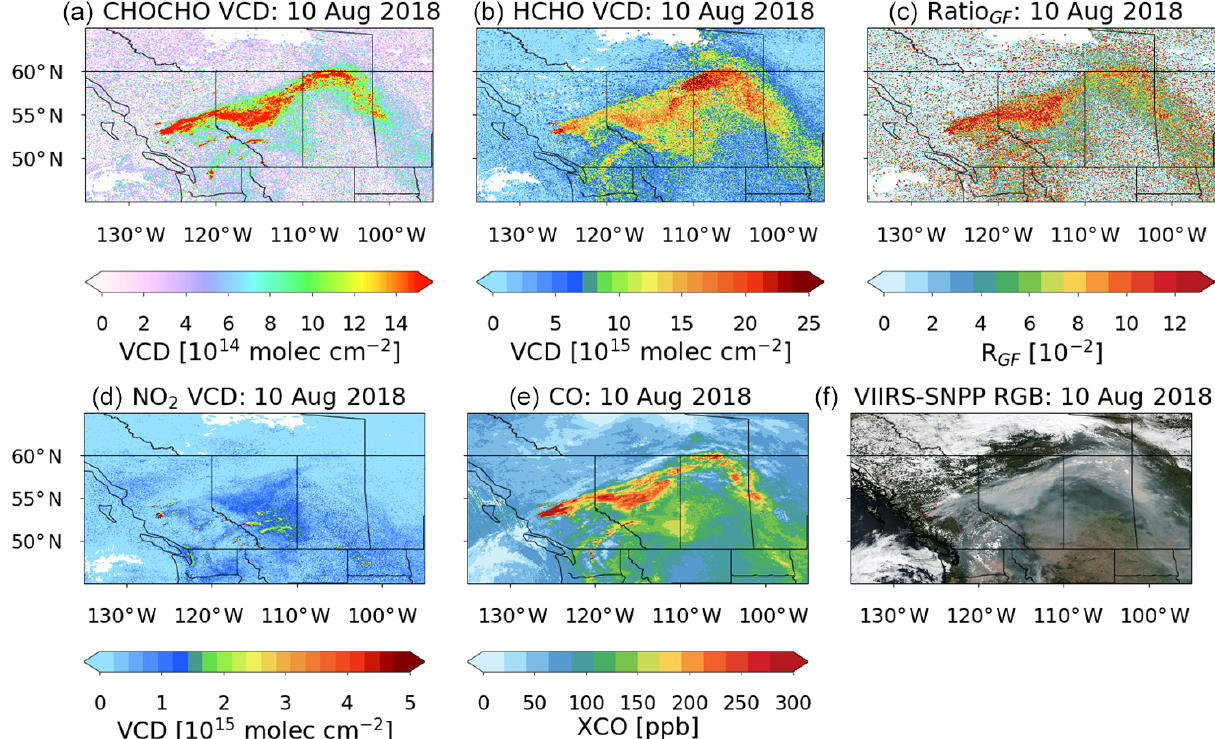
Figure 8. Panels (a) , (b) , (d) , and (e) show the CHOCHO, HCHO, NO 2 , and CO columns, respectively, retrieved from S5P measurements for 10 August 2018. Note that CO columns are unfiltered and only represent a qualitative description of the plume. The AMFs used for CHOCHO, HCHO, and NO 2 are appropriate for the biomass burning plume only. Panel (c) depicts the calculated CHOCHO-to-HCHO ratio ( R GF ) for the same day. Panel (f) shows a true-colour image of the aerosol distribution from VIIRS for 10 August